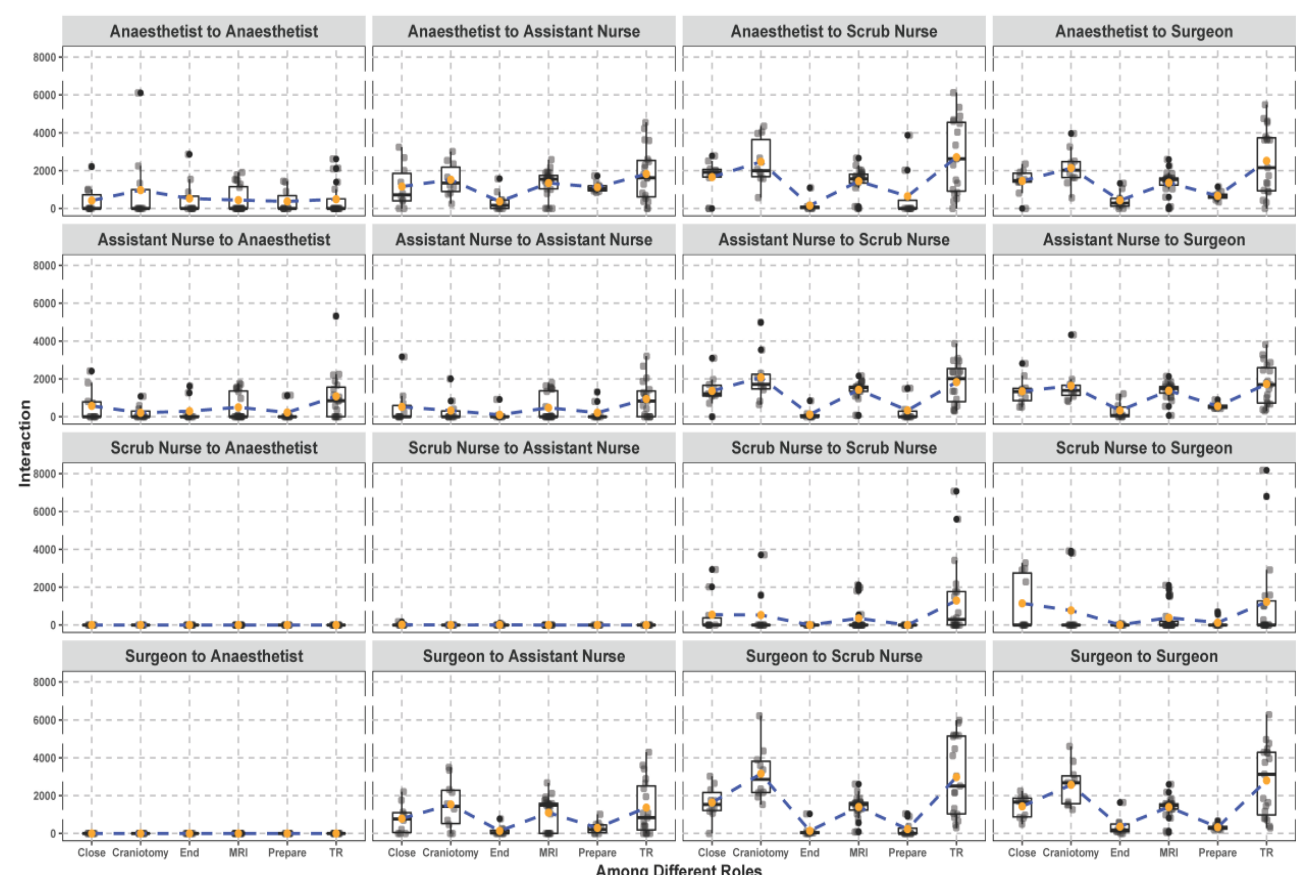
Figure 5. Trajectory-based interaction measurement between the surgical roles during